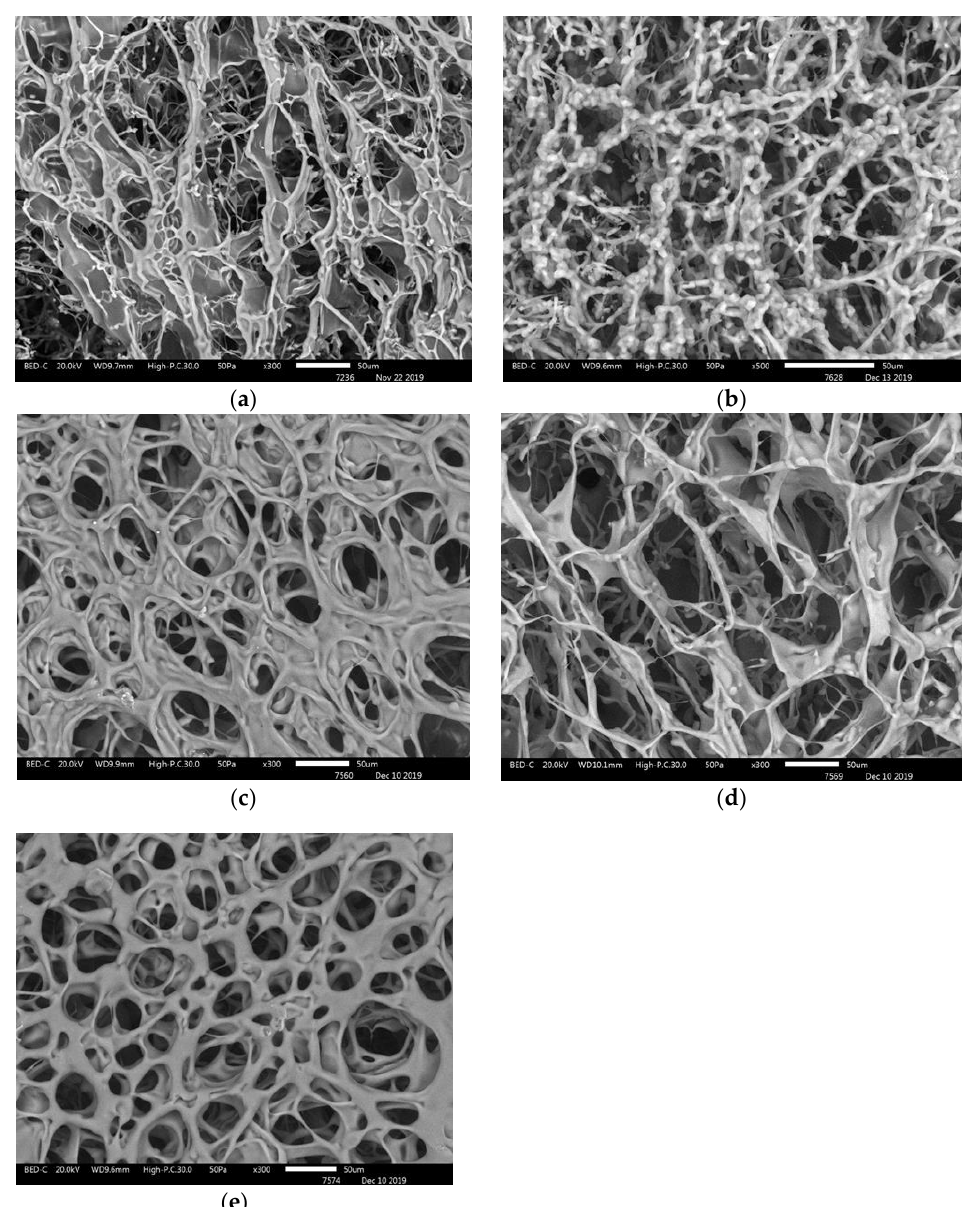
Figure 3. Structural SEM-photomicrographs of collagen ( a ), PAA ( b ), and copolymers of collagen and PAA synthesized at 25 ( c ), 45 ( d ), and 60 °C ( e ). Table 4. Tensile mechanical properties of films based on PAA, and collagen copolymers synthesized at 25, 45, or 60 ◦ C, and of pure PAA and collagen